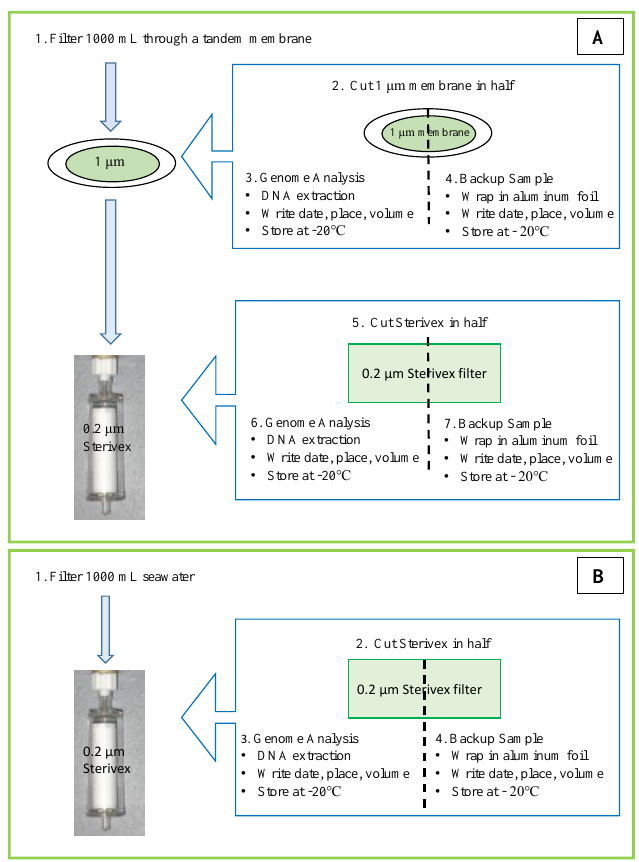
Figure 3. Sample preparation workflow for metabarcoding analysis: ( A ) 16S-rRNA: Water sample is filtered through a 1-μm pore-size membrane followed through a 0.2 μm pore-size membrane to capture attached and free-living bacteria, respectively. ( B ) 18S-rRNA: The water sample is filtered through only 0.2 μm pore-size membrane to capture phytoplankton. Each membrane is cut in half, one to be used for analysis and the other for back-up. Int. J. Environ. Res. Public Health 2020 , 17 , x FOR PEER REVIEW